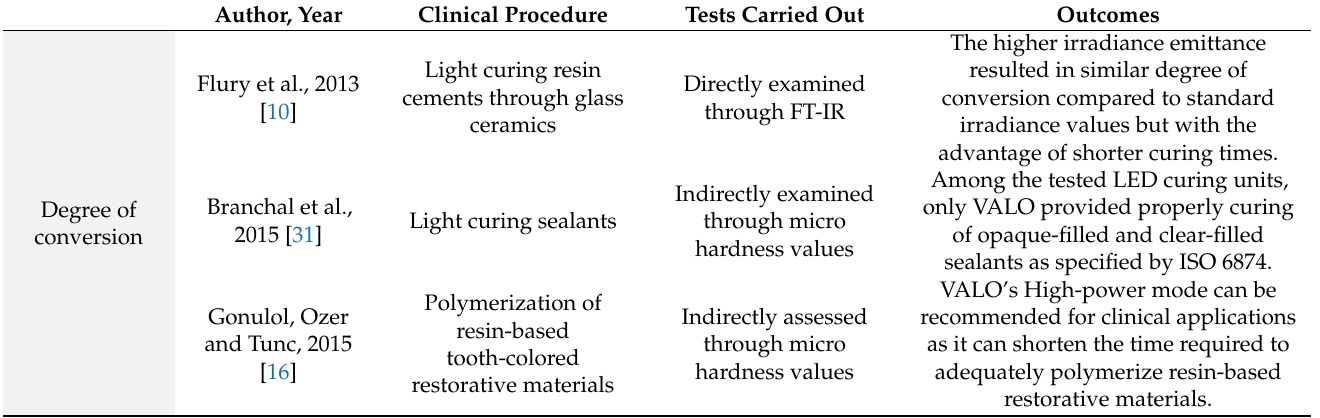
Table 6. Summary analysis of the main adverse events described on dental resin-based materials and on patients’ oral